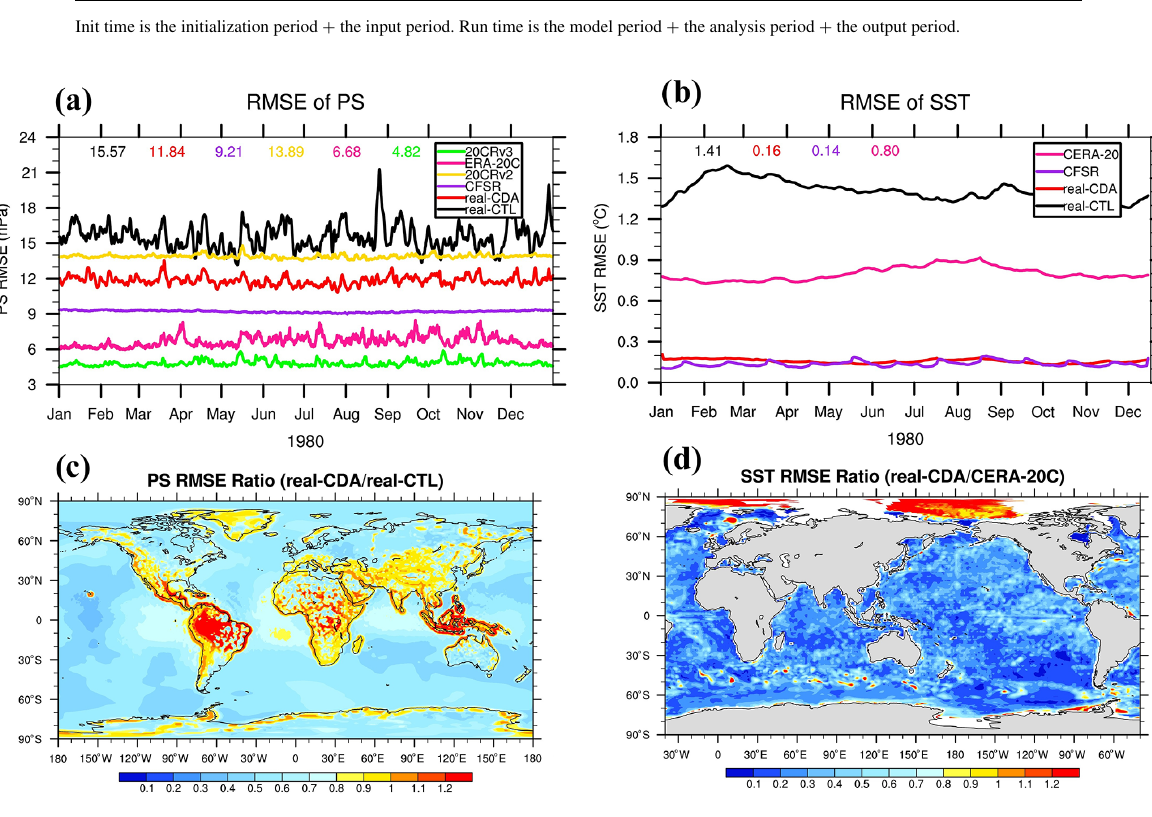
Figure 15. Time series of RMSE of (a) P s and (b) SST from the real-observation assimilation experiment and RMSE ratio distributions of P s (real-CDA/real-CTL) and SST (real-CDA/CERA-20C) in 1980. The numbers in (a) and (b) are RMSEs of the mean value corresponding to each